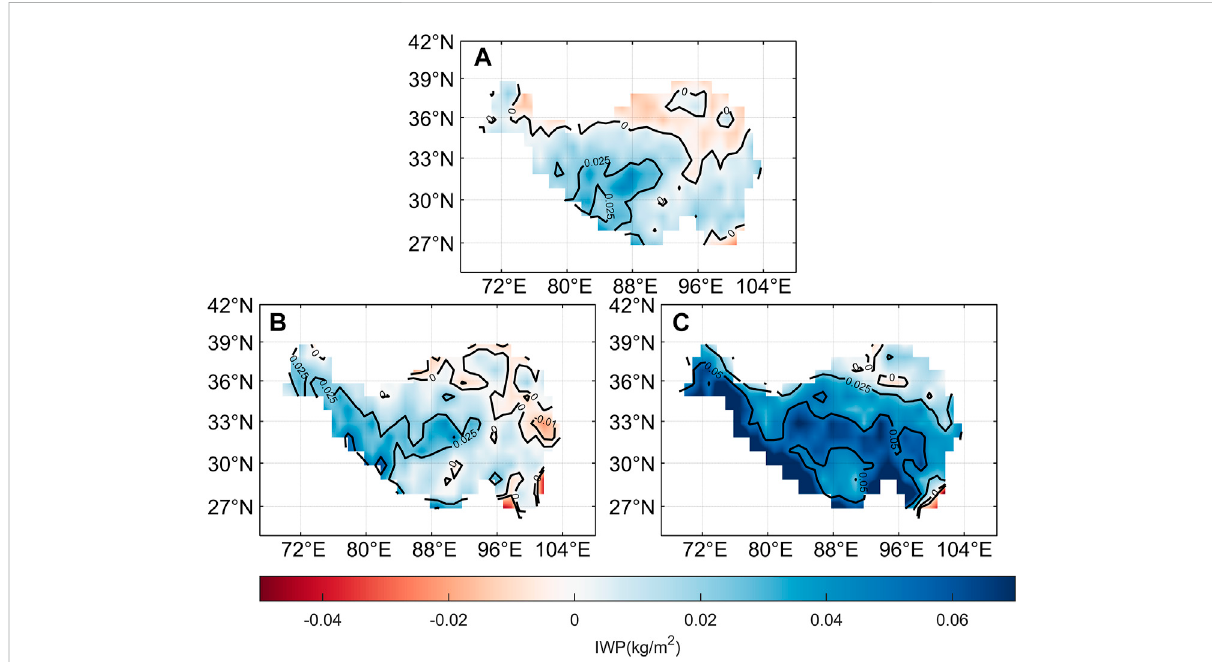
Spatial difference of atmospheric ice in winter between 2017 and 2019 retrieved by the three products. (A) Aqua, (B) Terra, and (C) Suomi NPP-